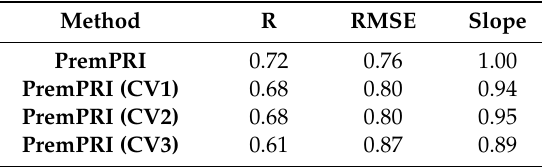
Table 1. The performance for PremPRI trained and tested on the S248 dataset and performing three types of cross-validation.